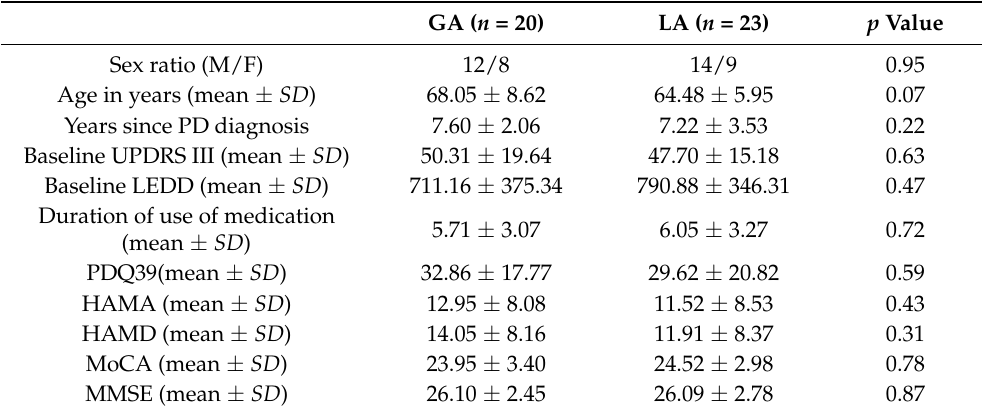
Table 1. Baseline patient characteristics of the two